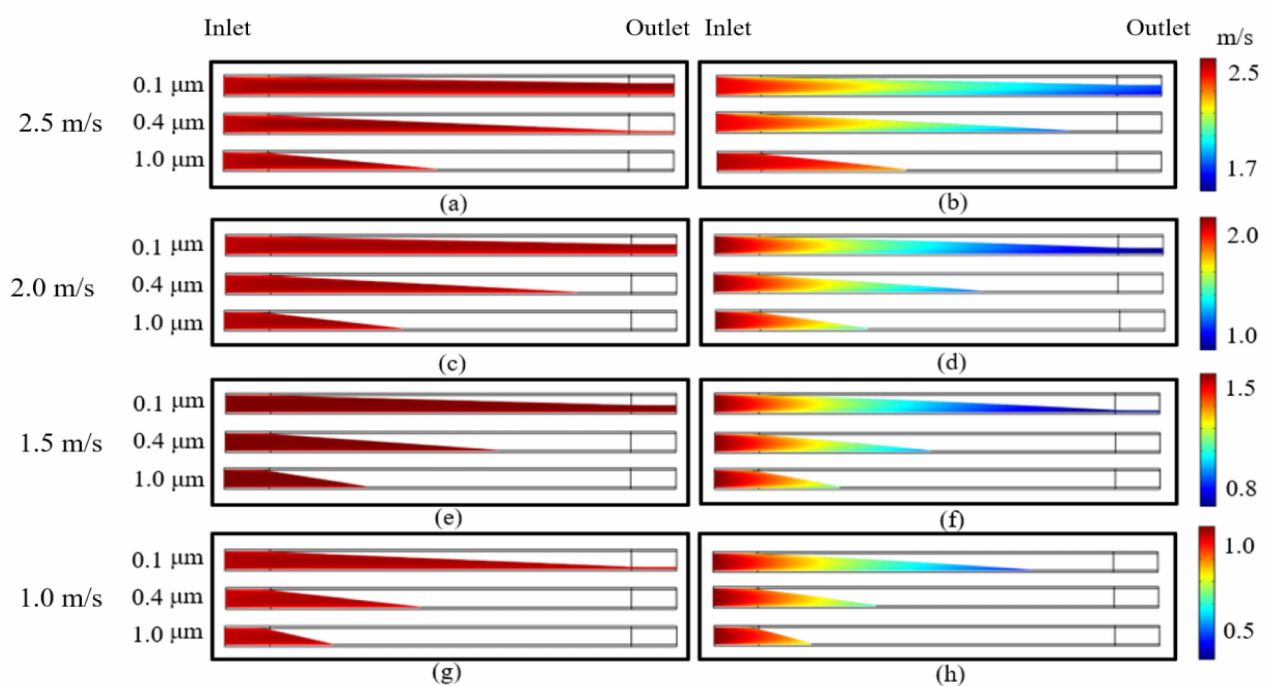
Figure 7. Movement of particles in the two micro-electrostatic filter channels under different air velocities: ( a , c , e , g ) show the combined plate-type micro-electrostatic filter at 2.5 m/s, 2.0 m/s, 1.5 m/s, and 1.0 m/s; ( b , d , f , h ) show the movement of particles in the cylindrical micro-electrostatic filter at 2.5 m/s, 2.0 m/s, 1.5 m/s, and 1.0